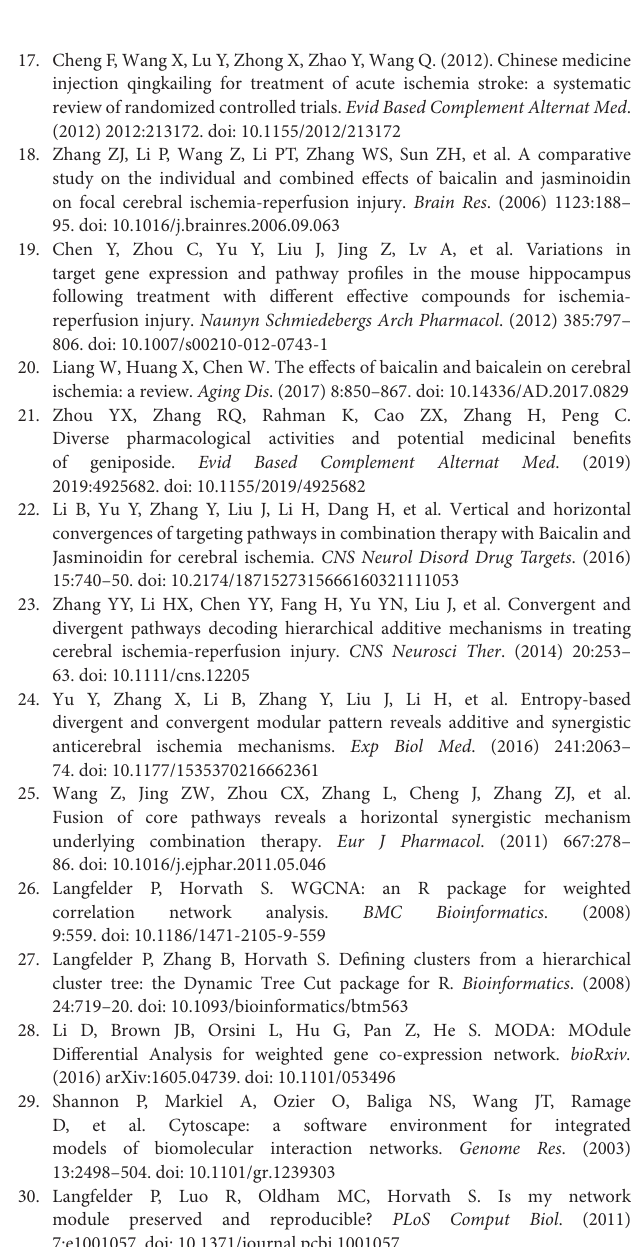
Supplementary Table 1 | The differentially expressed genes (DEGs) of three-drug groups and cerebral ischemia (CI) related genes. Supplementary Table 2 | The intersections among DEGs of three-drug groups and CI-related genes. Supplementary Table 5 | The expression level of DEGs in BJ (combination of baicalin and jasminoidin at a ratio of 1:1) group and its corresponding modules. Supplementary Data Sheet 1 | The relevant code/script used in this